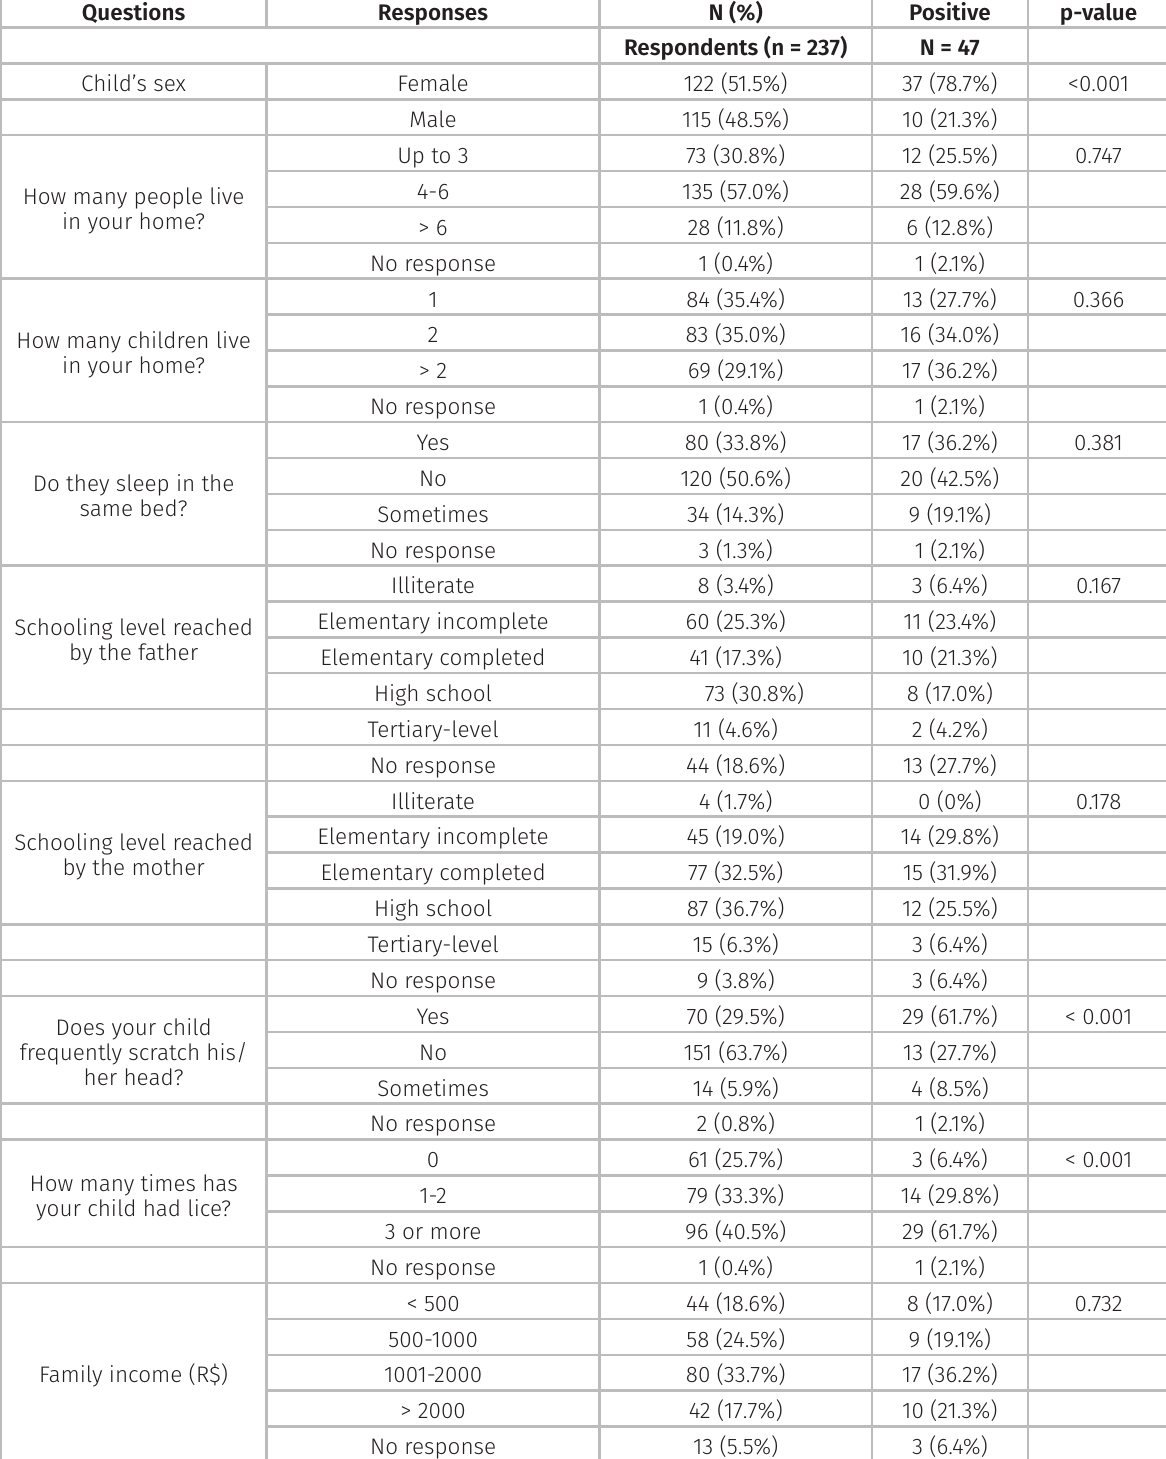
Table III. Results regarding positivity and socioeconomic information on the schoolchildren in years 1-5 at five municipal elementary schools in Niterói, RJ,